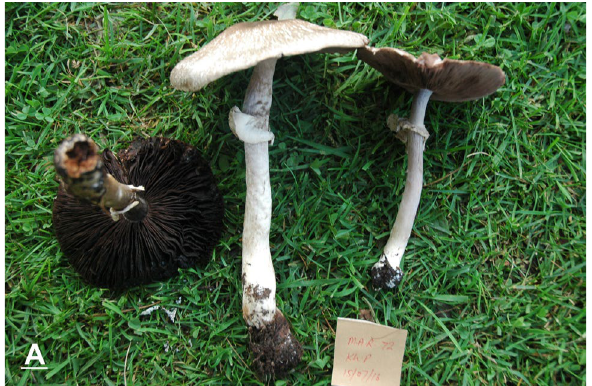
Figure 9. Macromorphological characters of A. gregariomyces. A basidiomata in the field. (A) KH72. Bars = 1 cm. Photographed by Dr. Hira